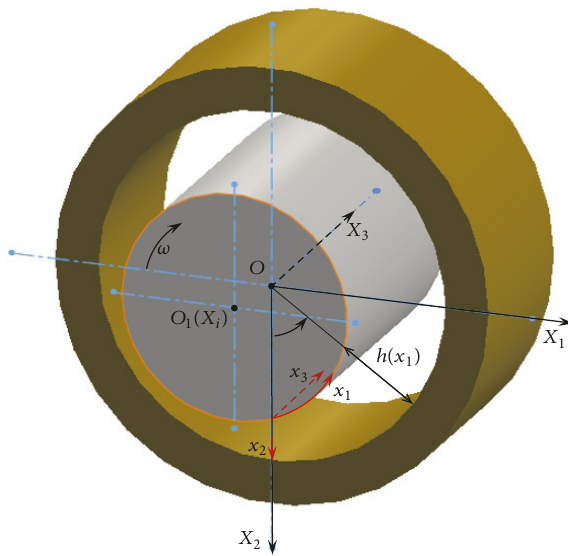
Figure 1: Calculation diagram of a journal